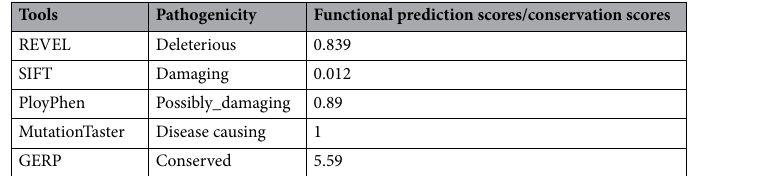
alignment shows conservation of the S807 residue of WFS1 across 9 species.